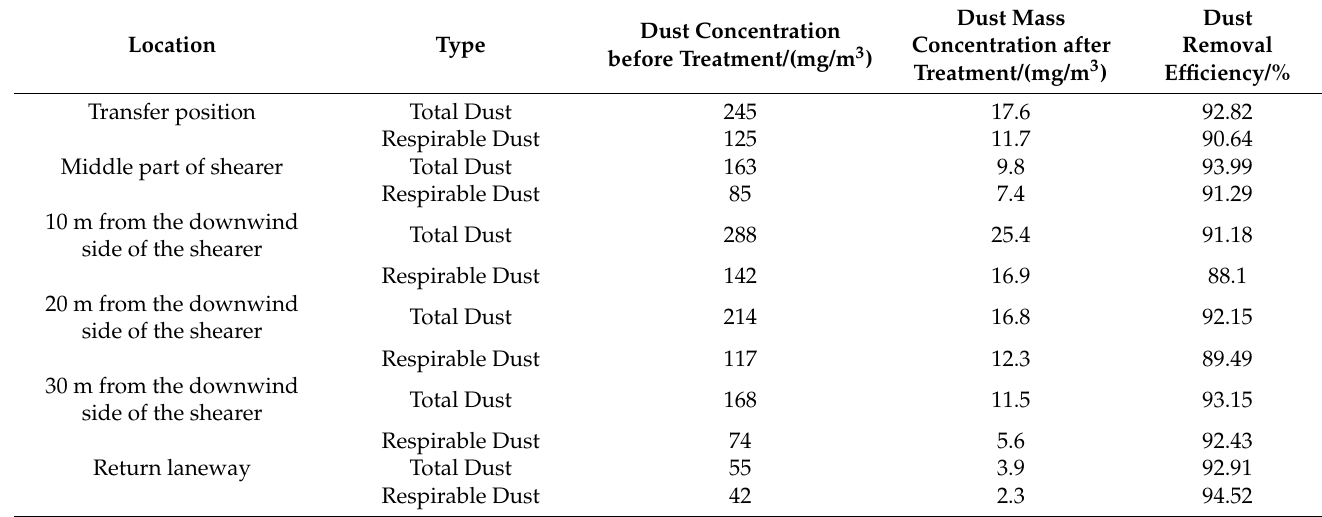
Table 2. Dust concentration before and after treatment at different sampling